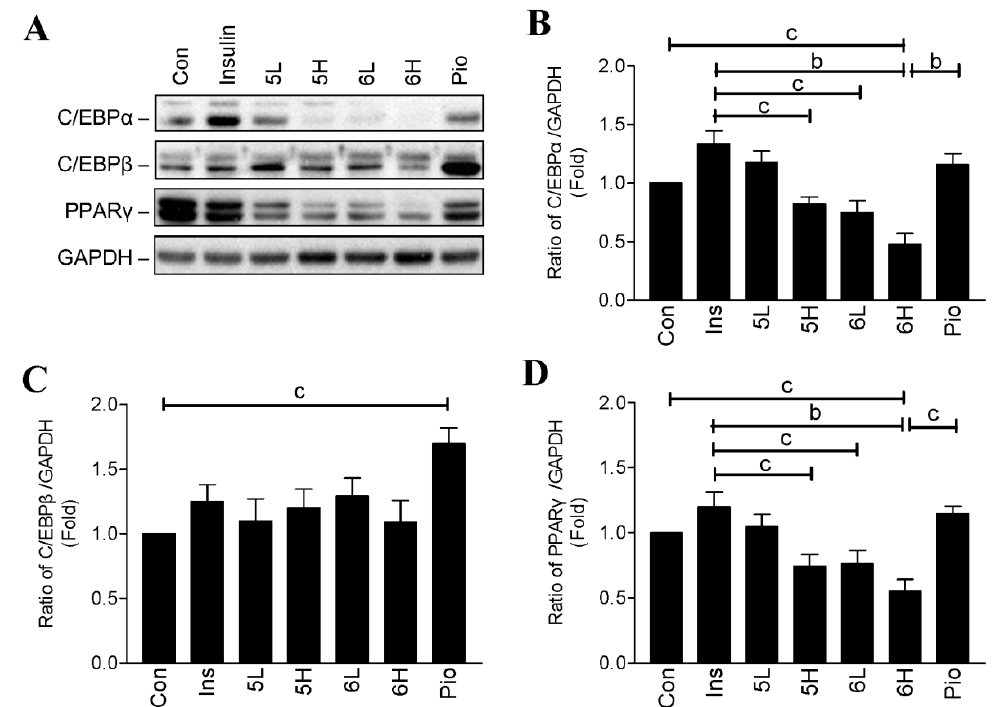
Figure 4. Effects of chalcone derivatives on the expression of CCAAT/enhancer binding protein- α and - β (C/EBP α , C/EBP β ), and peroxisome proliferator activated receptor γ (PPAR γ ) proteins in 3T3-L1 adipocytes. ( A ) 3T3-L1 adipocytes were treated with or without 0.32 µ M of insulin, low dosage (15 µ g/mL; L) or high dosage (30 µ g/mL; H) of compound 5 or compound 6 , or 30 µ g/mL of pioglitazone (Pio) for 24 h. C/EBP α , C/EBP β , and PPAR γ proteins were detected by Western blotting; ( B – D ) the quantitative results for the blots in panel A. Data are mean ± SD from three independent experiments. a : p < 0.001; b : p < 0.01; c : p <